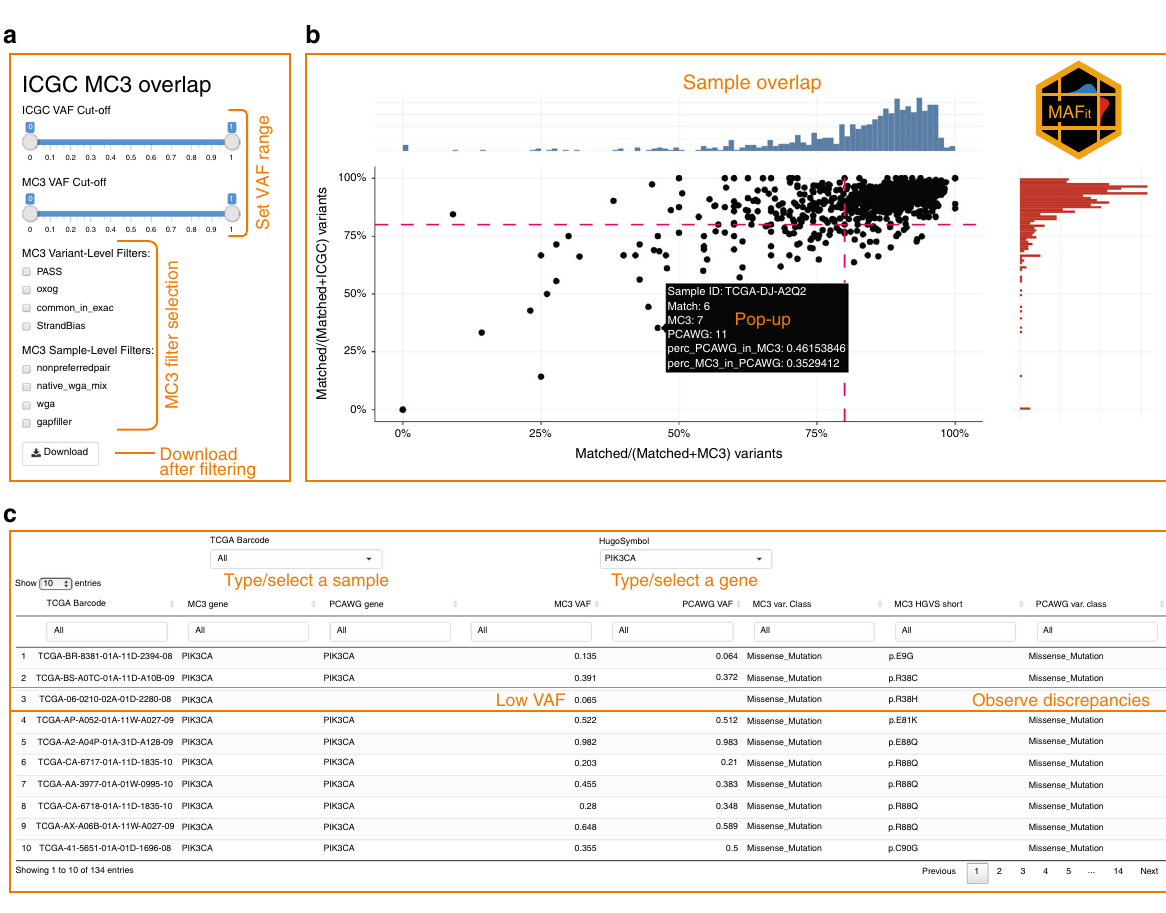
Fig. 4 Screenshots of online tool MAFit. Here we display screenshots from the MAFit on-line interface. Currently there are three main components to the interface: a A side panel shows sliders and radio buttons to fi lter data set to remain inclusive. In addition, a download button is available that will download the underlying data table. b MAFit rebuilds Fig. 2b in the fi rst tab of the on-line interface. Each alteration to the radio buttons or VAF sliders will result in an updated fi gure. In addition, if one ’ s hovers over a point on the scatter plot, a pop-up window will automatically display, providing the user with basic statistics used to calculate that point, i.e., total number of mutations, number of unique and matched mutations. c A table is also presented based on the selection criteria in panel a